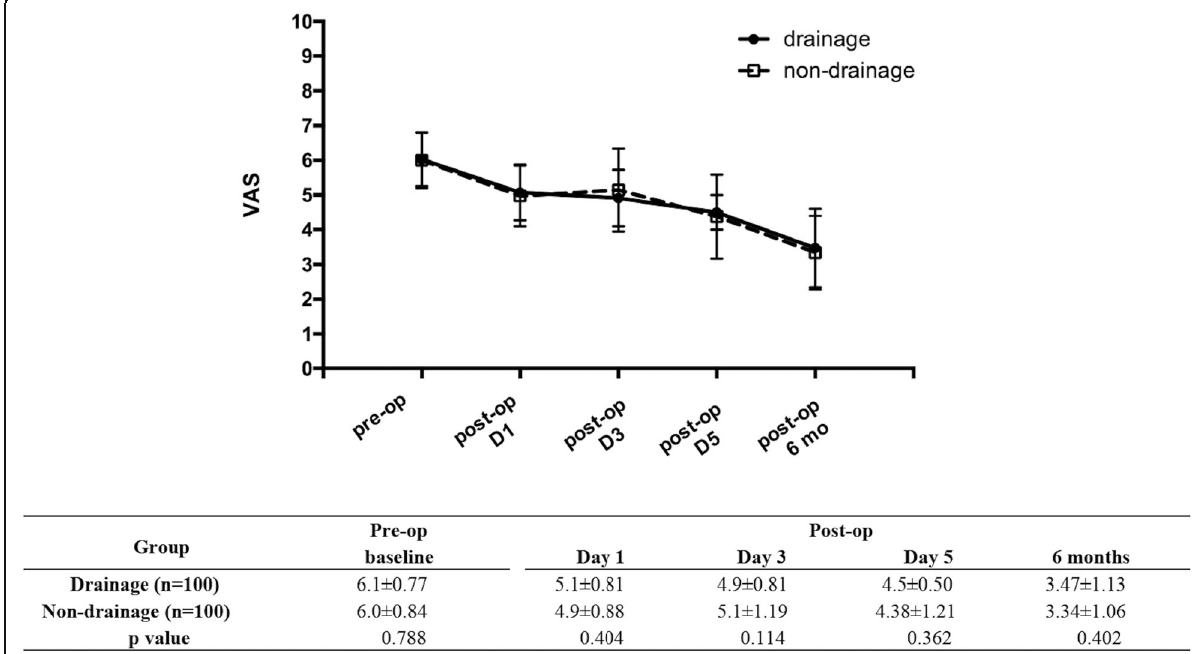
Fig. 3 Effect of drainage on VAS score after